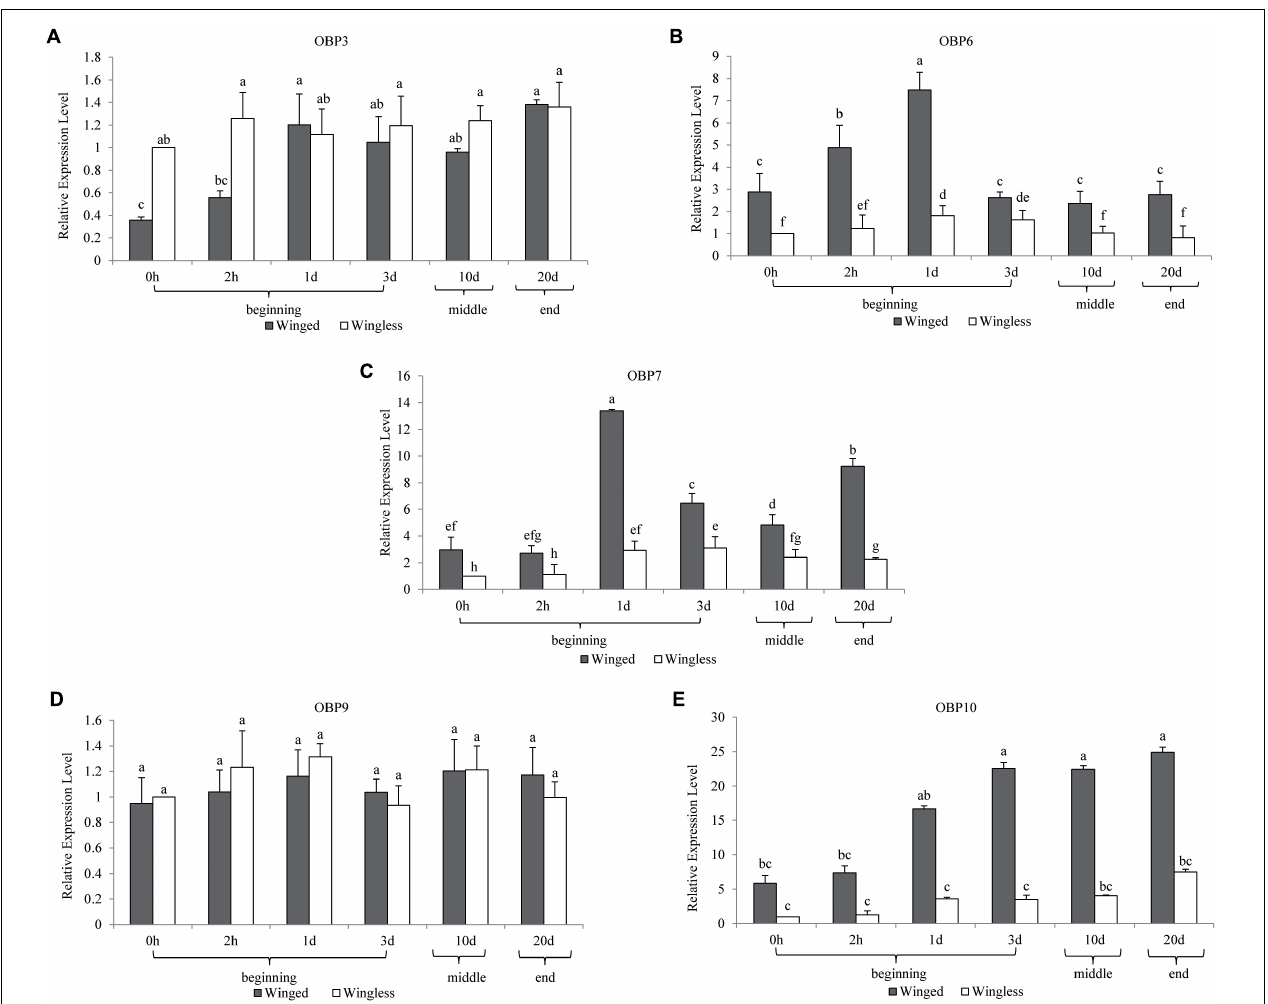
FIGURE 1 | Temporal expression profiles of OBP3/6/7/9/10 in S. miscanthi . Fold changes are relative to the antennal transcript levels of the wingless morph at 0 h after adult emergence. Differences in mean transcript levels were detected using one-way ANOVA, followed by Duncan’s multiple range test. Different letters over bars indicate significant differences ( p < 0.05). Winged, antennae of winged aphid; Wingless, antennae of wingless aphid; Beginning, middle, end, the adult stage after emergence was divided into three parts, namely, beginning (within 3 d), middle (10 d), and end (20